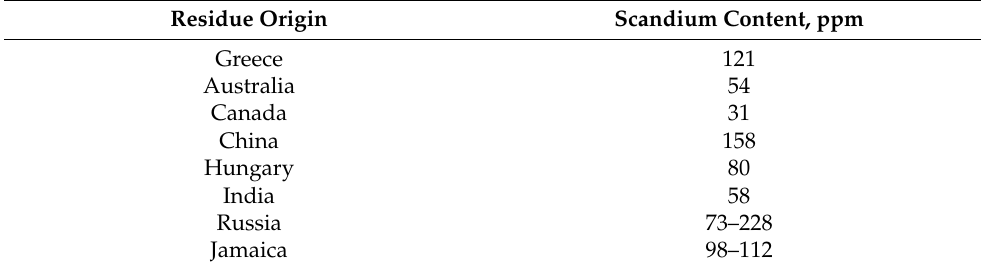
Table 2. Scandium content in the bauxite residues of different origin